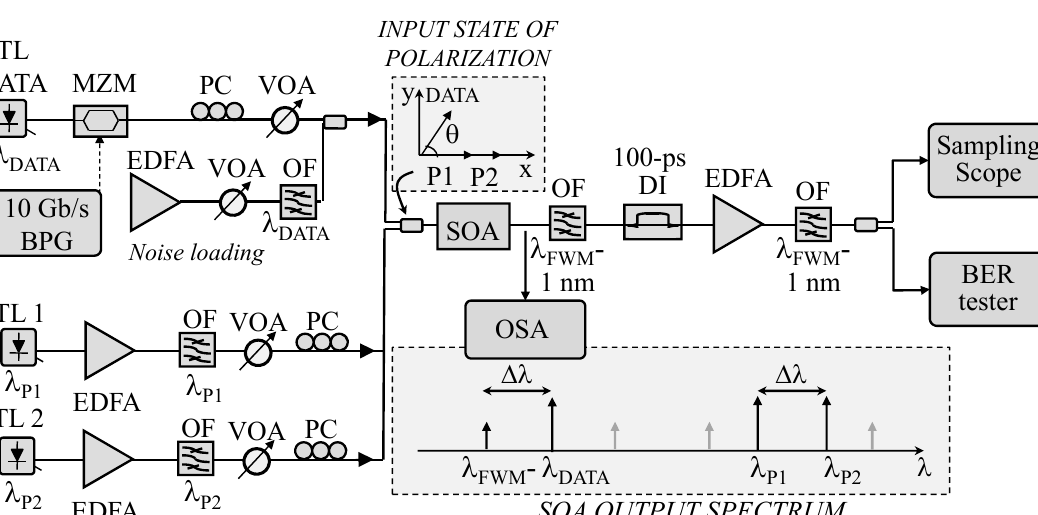
Figure 1. Experimental setup for polarization independent differential phase shift keying (DPSK) regenerative wavelength converter characterization. TL: tunable